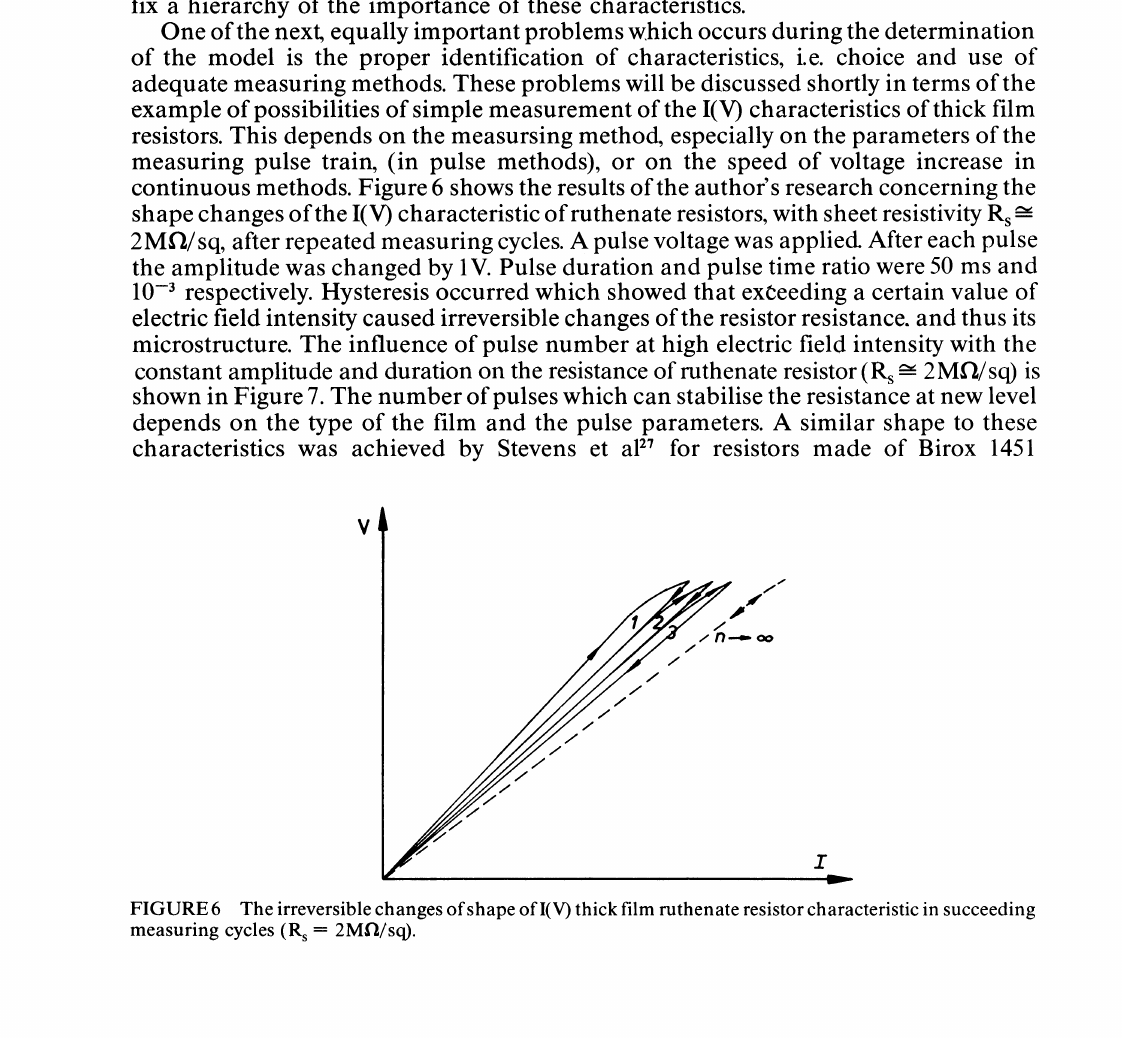
FIGURE 6 The irreversible changes of shape of I(V) thick film ruthenate resistor characteristic in succeeding measuring cycles (R